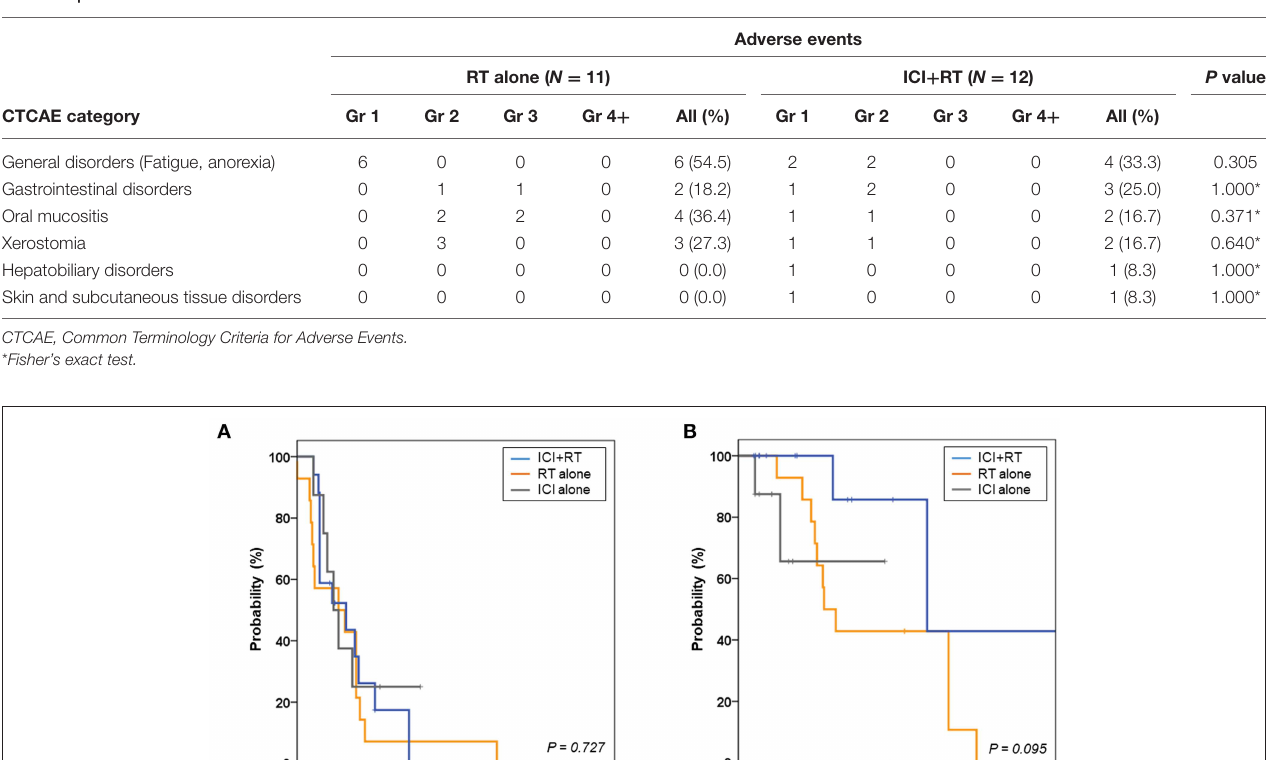
TABLE 3 | Radiation-related adverse events.